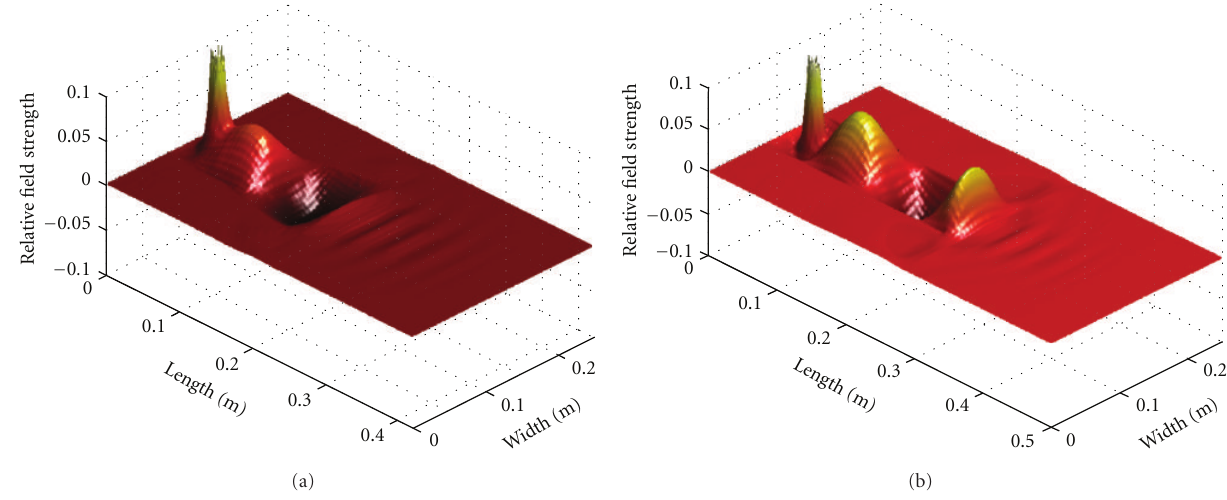
Figure 9: Comparison of microwave fields for (a) the 130mm by 43mm aperture horn antenna and (b) the 86mm by 20 mm aperture horn antenna.